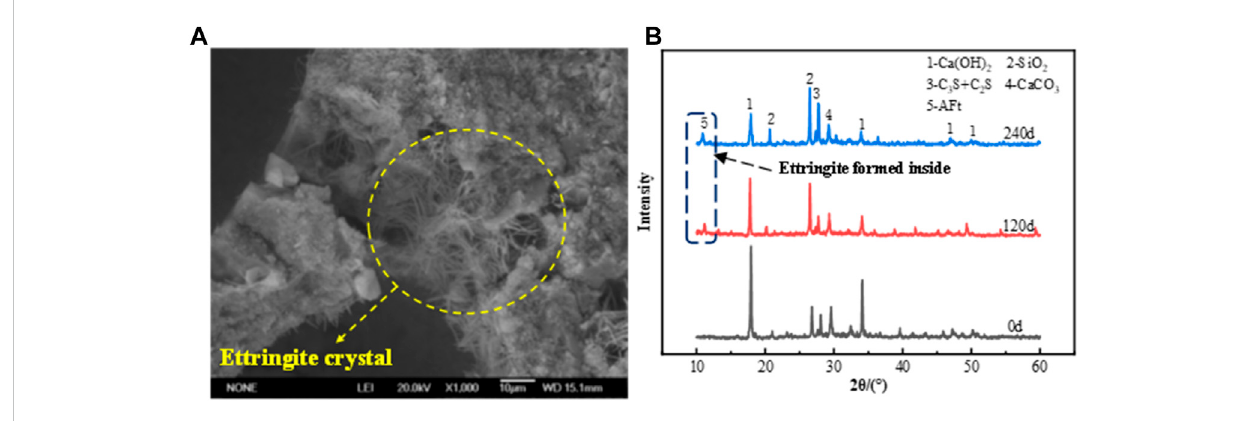
FIGURE 11 SEM (A) and XRD (B) patterns of eroded materials.